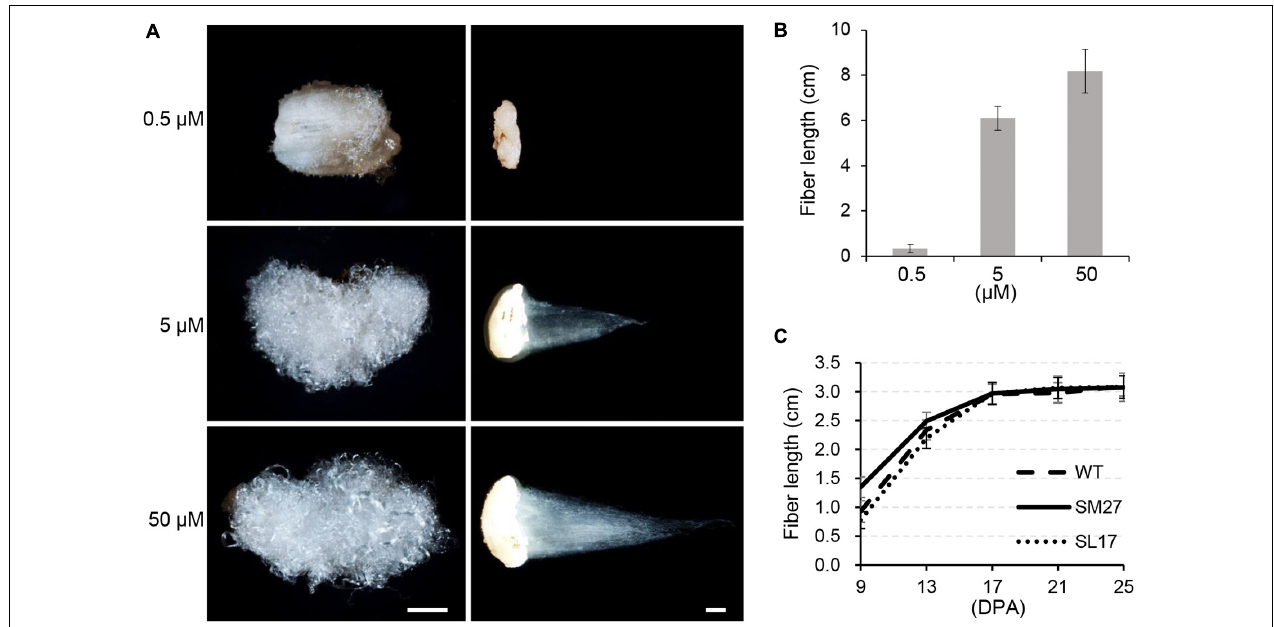
FIGURE 4 | Auxin promotes fiber elongation. (A) Indoleacetic acid (IAA) treatment increases fiber length in vitro . Scale bar = 1 mm. (B) Fiber length under IAA treatment in vitro . (C) Fiber length of transgenic cotton. SM, SCFP:iaaM transgenic cotton; SL, SCFP:iaaL transgenic cotton. Error bars indicate standard deviation ( n ≥